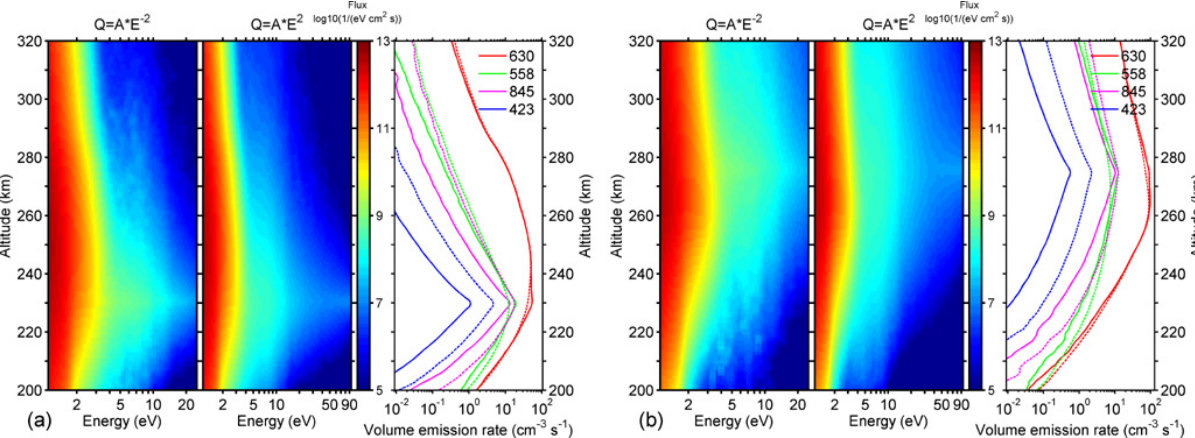
Fig. 8. (a) The electron differential flux and the volume emission rate for the heating pulse at 18:12UT. Left: Altitude energy variation of the electron flux for the power-law acceleration electron source with the exponent − 2. Centre: Same as the left panel with the exponent 2. Right: Volume emission rate profiles of the 630.0nm (red), 557.7nm (green), 844.6nm (magenta) and 427.8nm (blue) optical emissions. The solid lines correspond to the electron acceleration source with the exponent − 2, the dashed lines corresponds to the exponent 2; (b) same as panel (a) for the heating pulse at 18:54UT.